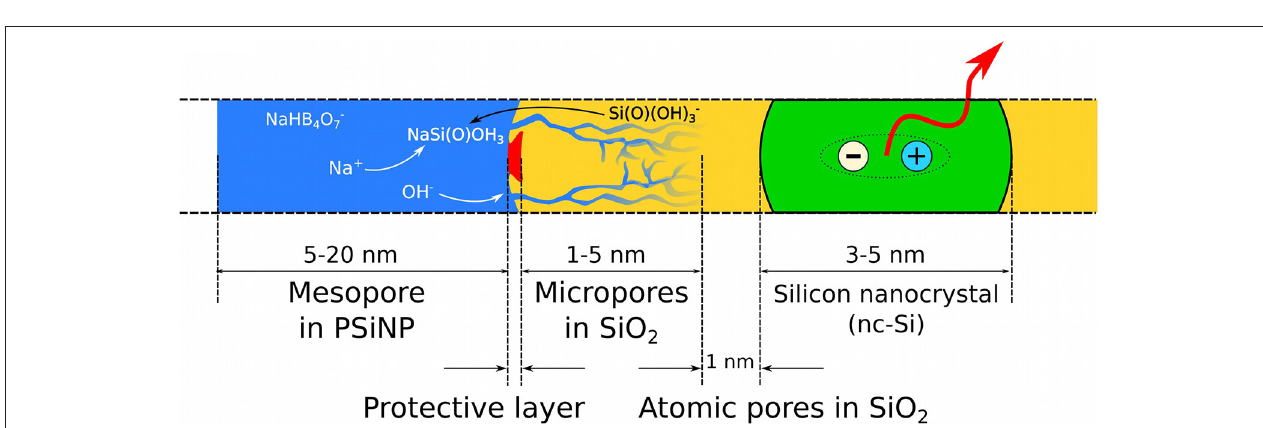
FIGURE 8 | XPS spectra of “fresh” and “aged” PSiNPs. Dots: experimental data for “fresh” (A,B) and “aged” (C,D) PSiNPS; Solid lines: approximation; Dashed: deconvolution into Gaussians.